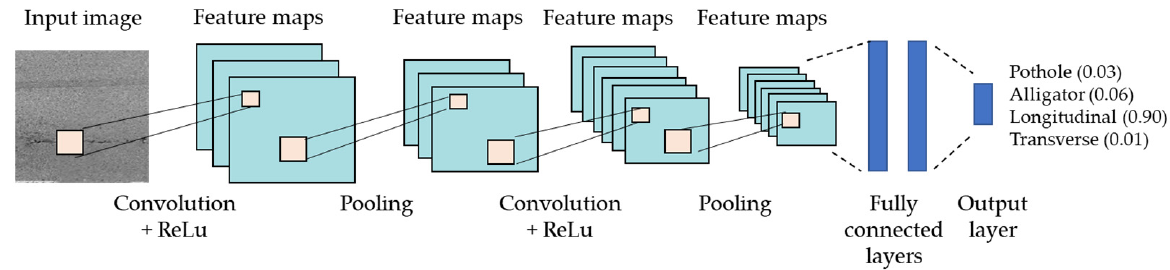
Figure 3. Illustration of the CNN architecture proposed in [13].